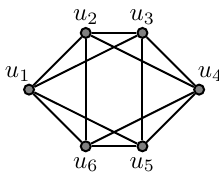
Figure 1: The graph G